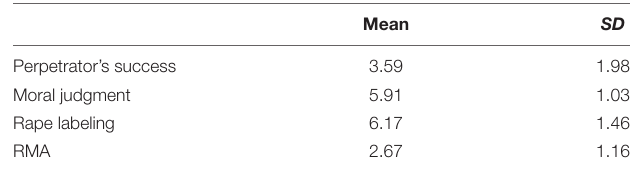
TABLE 4 | Descriptive statistics of Study 2.